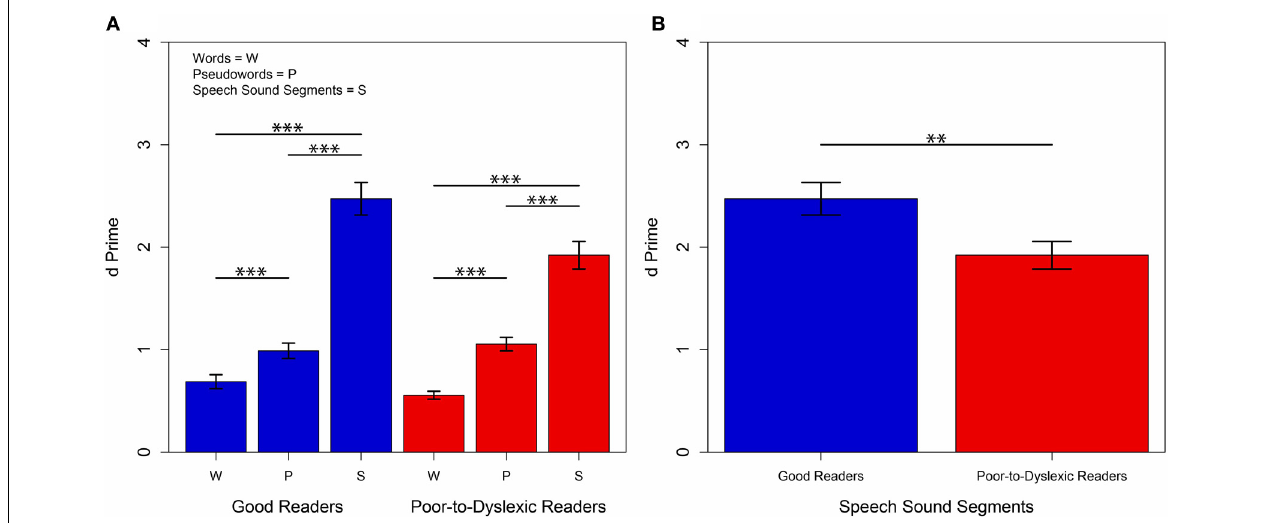
FIGURE 2 | Mean phonemic restoration performance by reading group: good readers and poor-to-dyslexic readers. Low d (cid:2) scores indicate more susceptibility to the restoration illusion. (A) Amount of restoration is shown as a measure of d (cid:2) for good readers and poor-to-dyslexic readers across the word (W), pseudoword (P) and speech sound segment (S) conditions. Stronger restoration was found for words compared to pseudowords, words compared